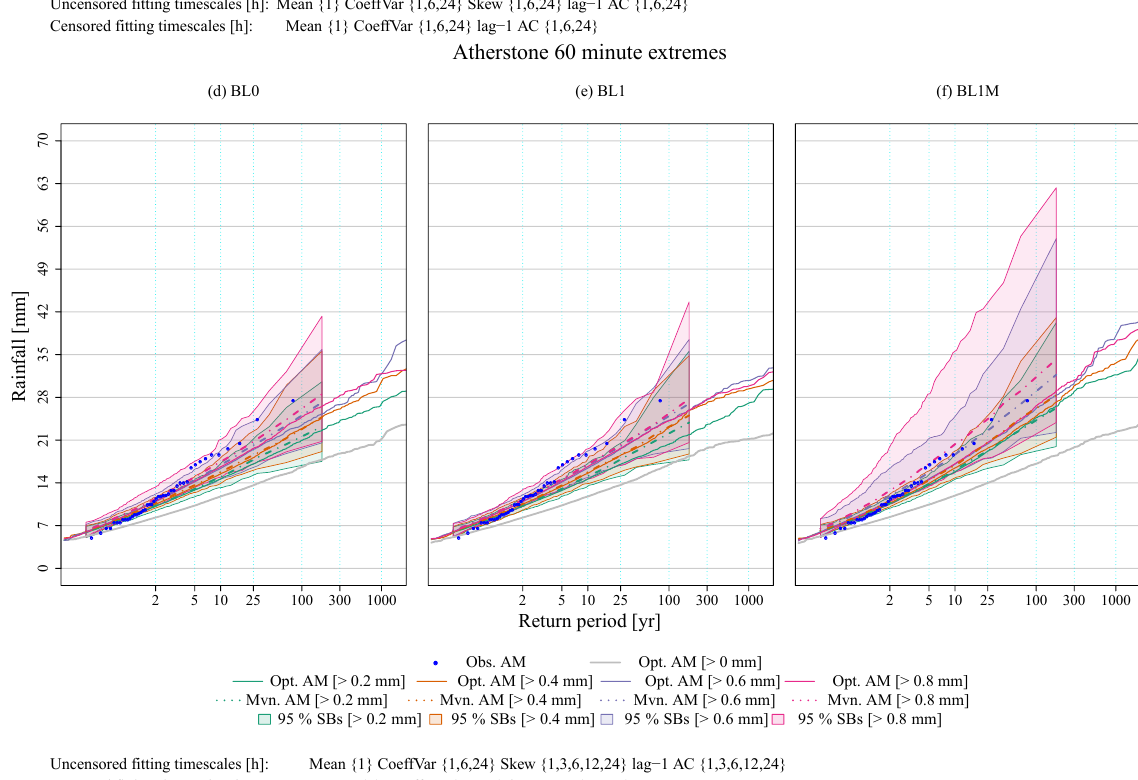
Figure 6. Extreme value estimation at 60min resolution. Optimal realizations (opt. AM) are shown with solid lines and the means of the MVN realization (mvn. AM) are shown with dashed lines. Simulation bands (SBs) are shown with filled polygons.